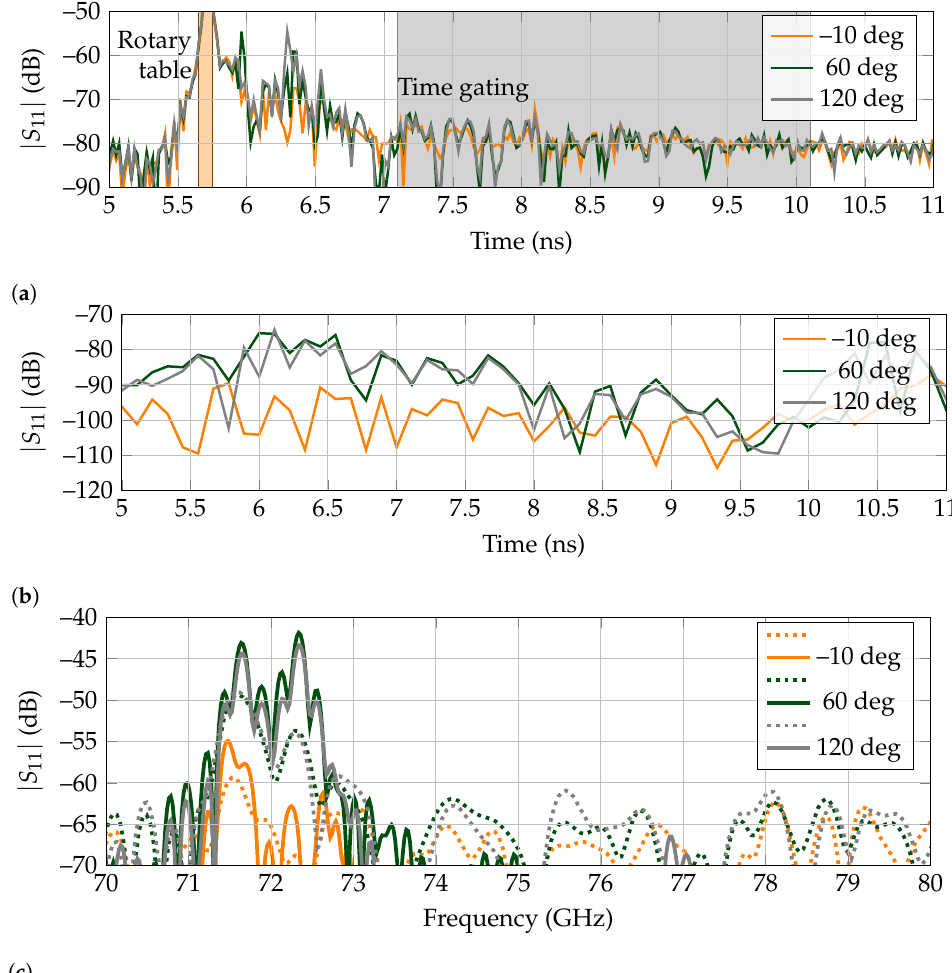
Figure 11. Selected backscattered responses for the high-Q tag in the cluttered scenario. ( a ) Measured time responses. Time gating is marked in gray and spans from 7.1 ns to 10.1 ns. The early reflection of the rotary table is marked in orange. ( b ) Extracted time-domain backscatter response of the tag by the RPCA. ( c ) Received frequency response, where dashed lines indicate time-gating and solid lines RPCA. The plot is represented between 70 GHz to 80 GHz to facilitate comparison at